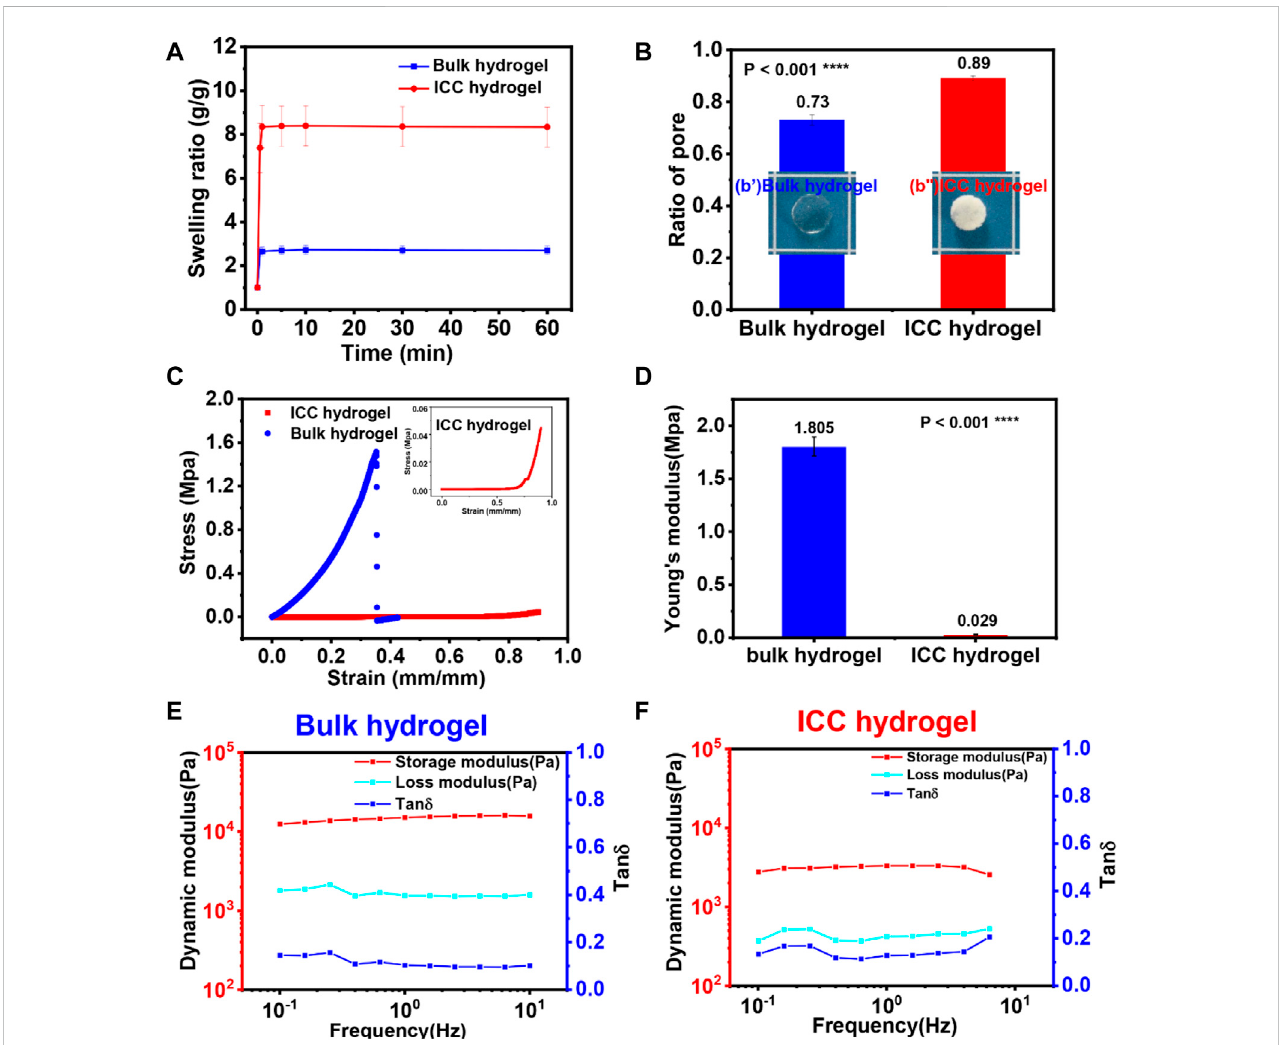
FIGURE 3 (A) Swelling kinetics of GelMA bulk and ICC hydrogels. (B) The ratio of pore of GelMA ICC and bulk hydrogels. (b ’ ) & (b ” ) Images of GelMA bulk and ICC hydrogels (C) Strain-stress (S-S) curve of GelMA bulk hydrogels (blue) and GelMA ICC hydrogels (red). Inset image is the S-S curve of ICC hydrogels (red). (D) Young`s modulus was calculated from the strain-stress curve in the range of 0 – .15 strain (right fi gure). Each sample was tested three times. (E,F) Storage modulus (G ′ ), Loss modulus (G ″ ) and tan δ of the GelMA bulk hydrogels (left) and GelMA ICC hydrogels (right) measured by parallel plate rheology. Each sample was tested three